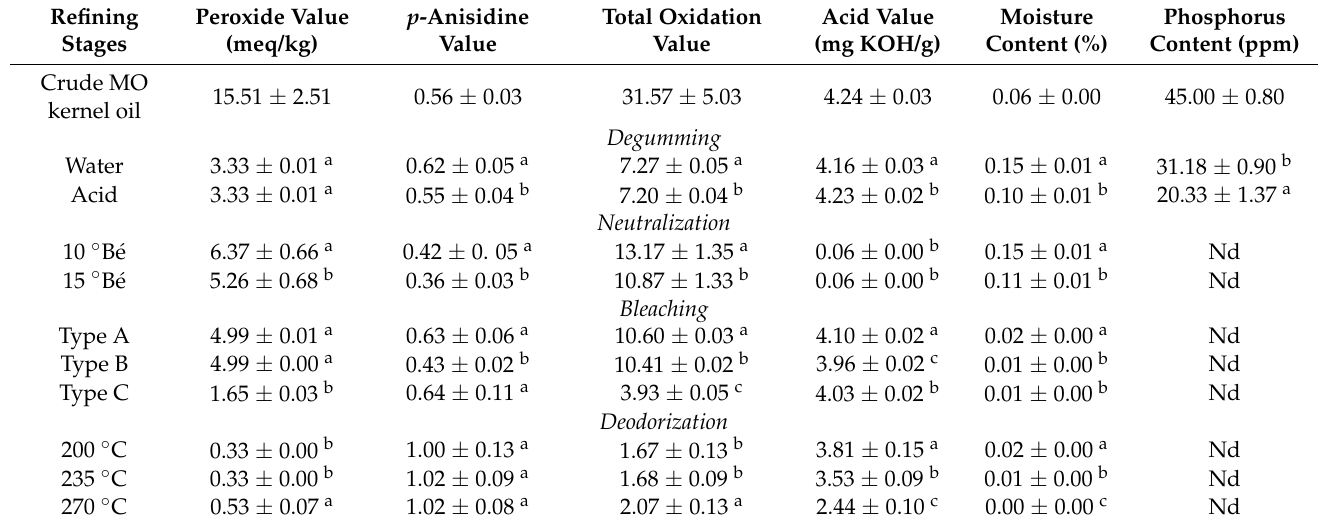
Table 2. Effect of individual refining steps on the physicochemical and oxidative properties of Moringa oleifera (MO) kernel oil.